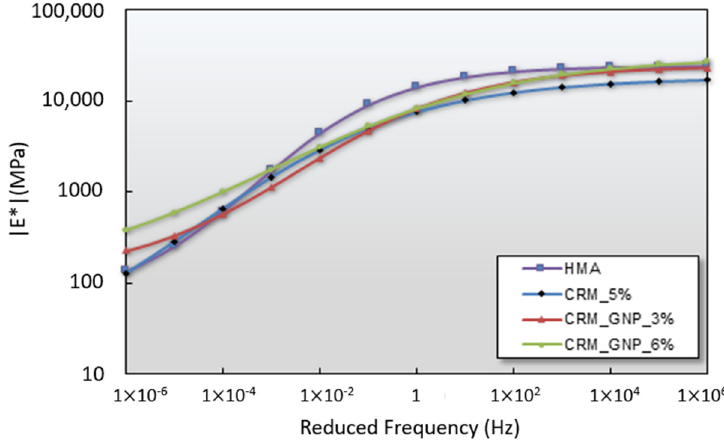
Figure 13. Dynamic modulus test results.